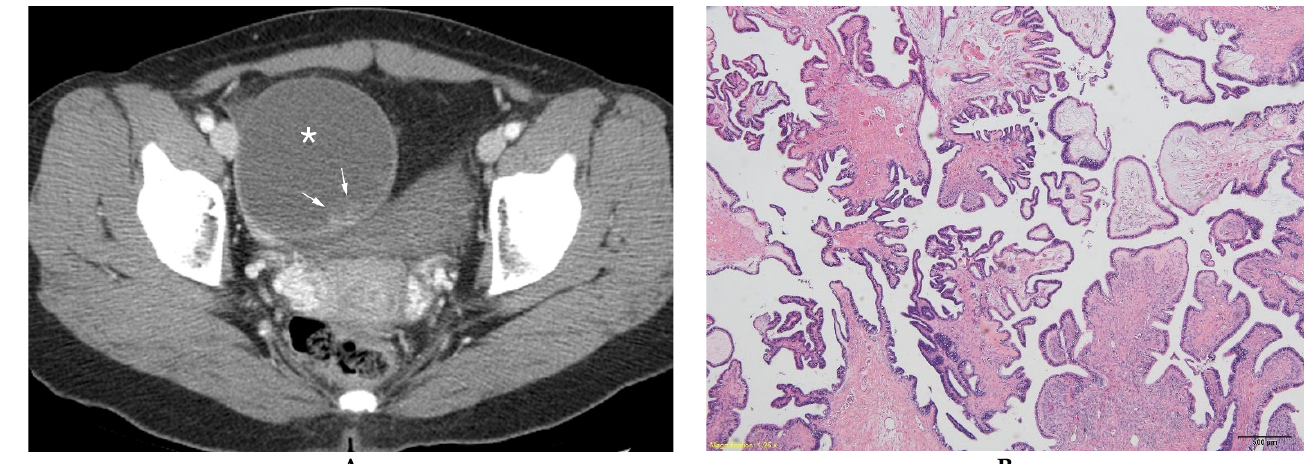
Figure 2. Serous borderline ovarian tumor in a 27-year-old woman. ( A ) Contrast-enhanced axial CT shows a unilocular cystic mass (*) with an ill-defined solid component (arrows) in the right ovary. ( B ) Microscopically, tumor cells present nuclear atypia and cellular proliferation without stromal invasion (hematoxylin and eosin 40×).